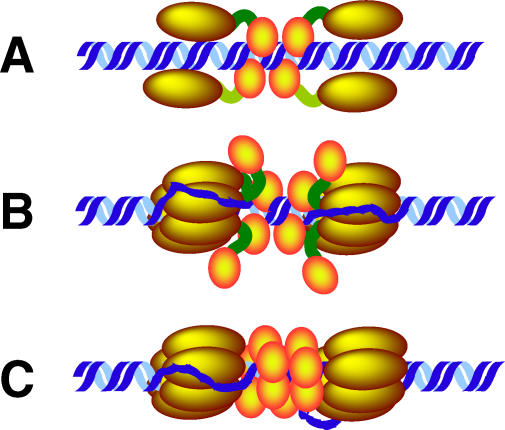
Schematic of SV40 T-ag Assembly on Origin DNAThe SV40 origin dsDNA is depicted as two ribbons. The SV40 T-ag N-terminal J domain is omitted for clarity. The SV40 T-ag domains are depicted as follows: the obd (yellow spheres), the helicase domain (yellow ellipsoids), and the flexible linker that connects them (green).(A) The T-ag obd binds its high-affinity GAGGC sites. The T-ag obd anchors the protein on the four GAGGC pentamers and thus orients the helicase domain for appropriate DNA strand selection in the subsequent steps. The obds on P2 and P4 are shown as transparent spheres to indicate that they are not crucial for single-hexamer formation but are required for unwinding. The helicase domains may interact as monomers with the DNA in a non–sequence-specific manner at this point.(B) Once the origin has been recognized by the obds, the two helicase domains each hexamerize around one strand of DNA. As a result, one strand goes through the central channel of the helicase domain, and the other traverses the surface of the helicase domain. This is consistent with the crystal structure of the E1 helicase domain with ssDNA [20], and this model is similar to that proposed for other hexameric helicases [50]. It is not known whether the DNA at site II is melted at this point or not. Twelve obds are now in close proximity and may now interact with one another despite relatively weak affinities.(C) Interaction between the two hexamers could occur through a series of obd–obd structural rearrangements wherein these domains transition from the site-specific complex with the A1 and B2 loops fully engaged with the DNA, to a structure where loop B3 makes contacts across a pair of obds (possibly as spirals). The A1 and B2 loops are now oriented away from the central channel (and are proximal to the helicase domains). The open ring spiral hexamer of the T-ag obd would allow access of ssDNA from the outside surface of the helicase domain to the center of the channel. This channel is positively charged and sufficiently wide (approximately 30 Å) to accommodate two ssDNA strands moving in opposite directions. It is likely that the obds are dynamic and fluctuate between differing states of interaction, including aclosed hexameric ring, depending on the requirement to interact with ssDNA, dsDNA, or other factors, such as the SSB hRPA. The double hexamer is now assembled and ready to recruit other host factors necessary for replication (for a review, see [3]).